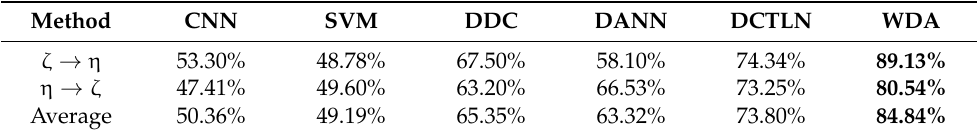
Table 4. Accuracies of methods under different transfer conditions.